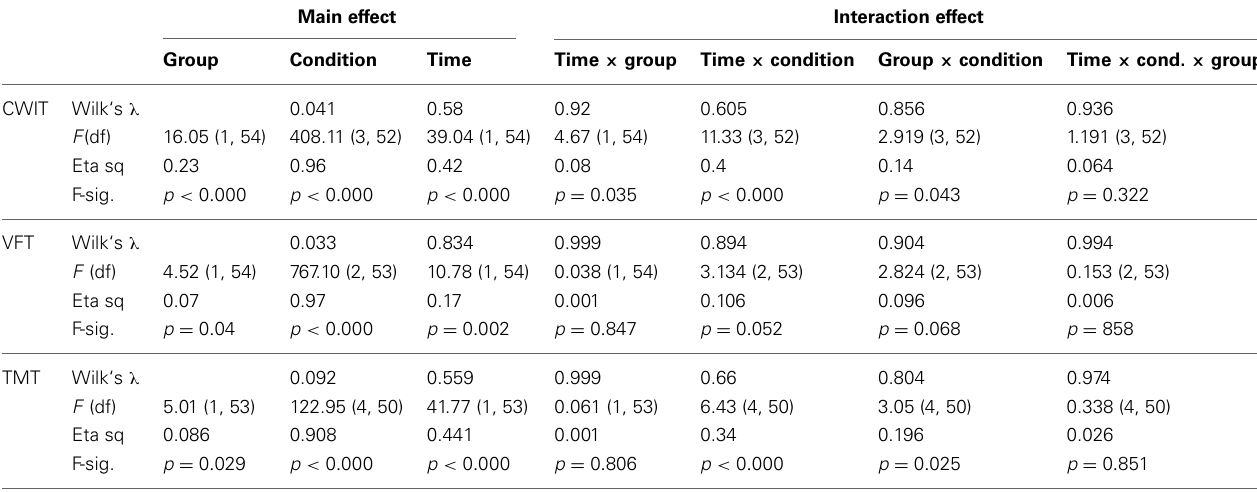
Table 3 | Cognitive performance in the patient group and control group across T1 and